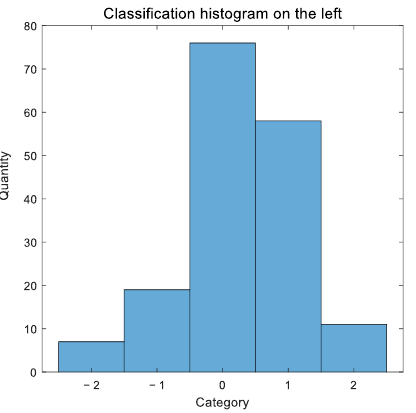
Figure 10. Classification histogram on the left.